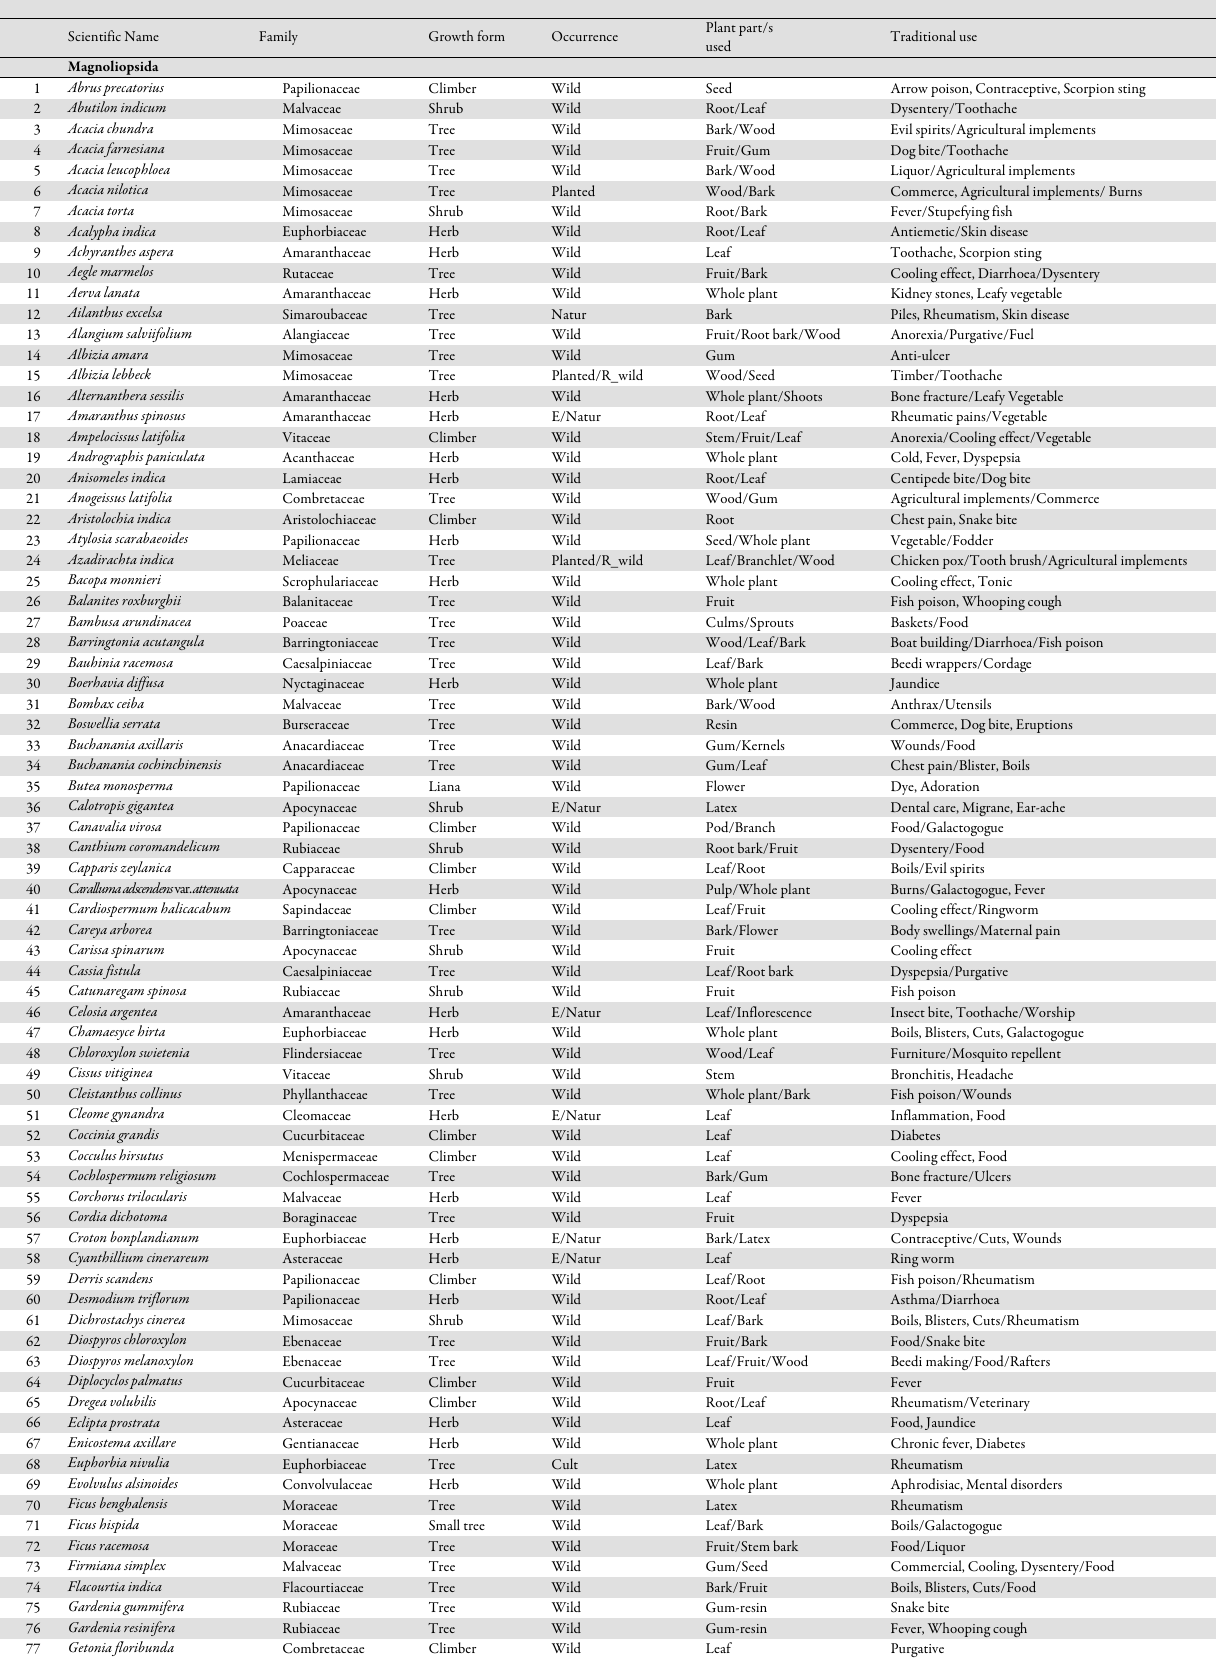
Table 1. Documentation of ethnobotanical plants from Pocharam wildlife